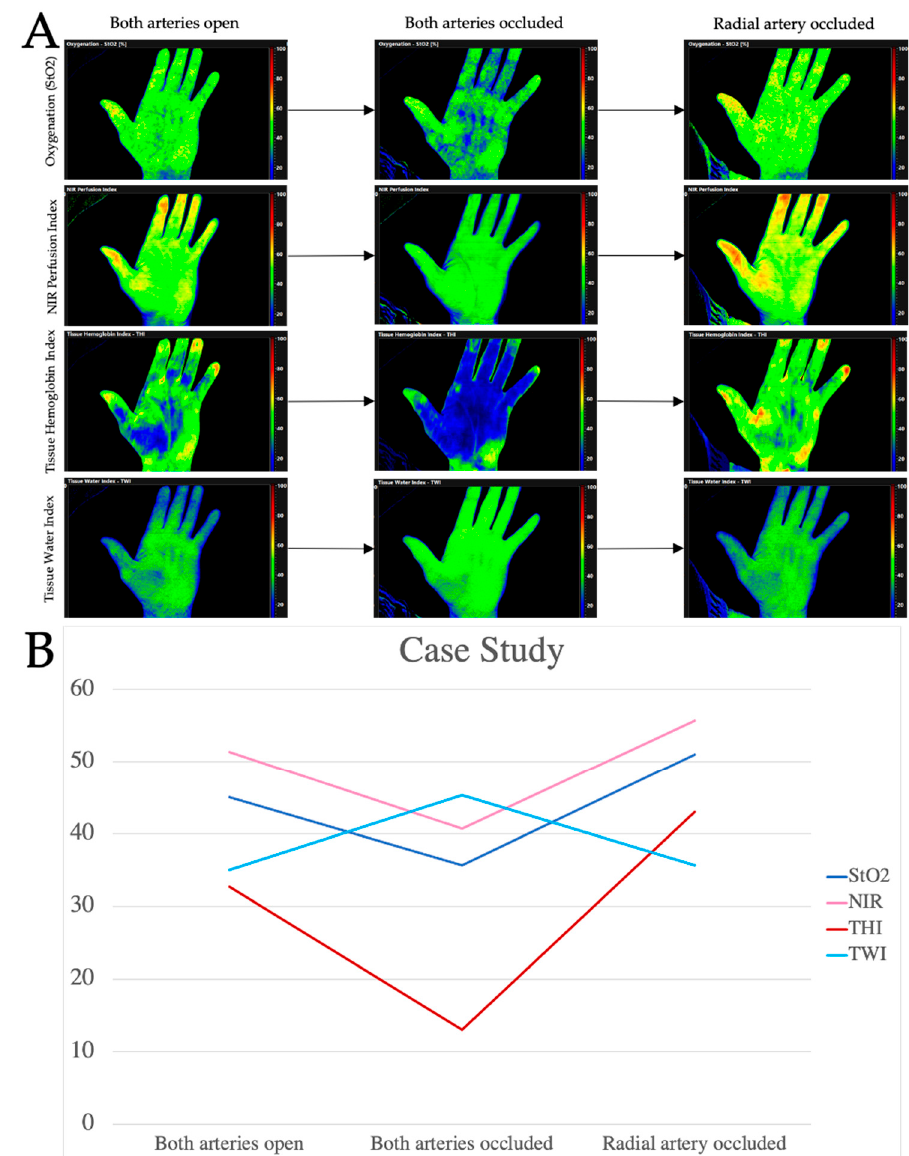
Figure 7. In ( A ) the measurements at the three different time points are shown. A baseline measurement was taken (time point I, both arteries open), then both, the radial and the ulnar artery were occluded (time point II) and at time point III, the ulnar artery was released. At time point I, tissue oxygenation (StO 2 ) was 45%. After occluding the arteries, the values decreased to 35.67% and increased again after release of the ulnar artery (51%) as can be seen in ( B ). This observation is consistent with the measurements of the NIR perfusion index (NIR) showing values of 51.33 at time point I, 40.67 at time point II and 55.67 at time point III (see B). The image shows very impressively the trend of the hemoglobin index (THI) during the course of the experiment. With both arteries open, the THI was 32.67; after occlusion of both arteries, the values decreased to 13 and increased again after release of the ulnar artery (43). As can be seen in the images in A, tissue water index (TWI) increased during artery occlusion showing values of 45.33 while both, the baseline measurement and the measurement after release of the ulnar artery showed values of 35. The Return-to-perfusion (RTP) value indicates the difference in percent between the measurements at time point III and time point I. Here, RTP-values for StO 2 were − 13.33%, for NIR − 8.46%, for THI − 31.62% and for TWI − 1.91%. Those values corresponded to a strong return to perfusion after release of the ulnar artery showing a save perfusion of the hand by the ulnar artery